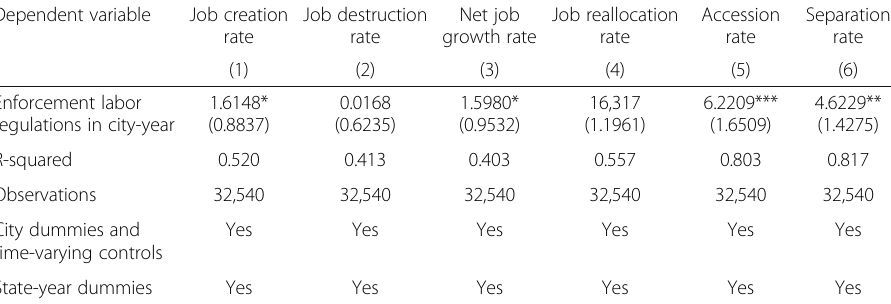
Table 9 Enforcement of labor regulations and job flow rates, controlling for state time